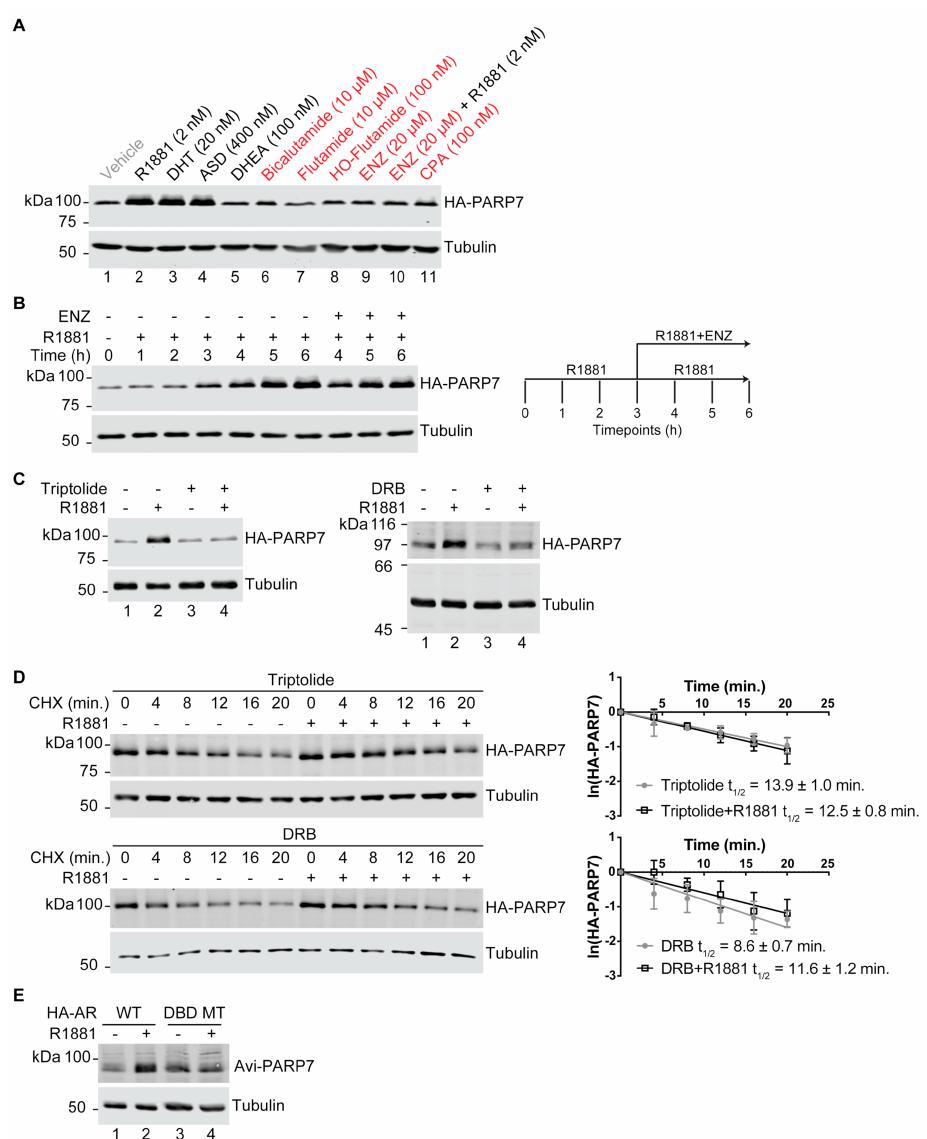
Figure 6. AR-dependent transcription is required for PARP7 stabilization. ( A ) PC3-Flag-AR/HA- PARP7 cells were treated with indicated androgens (black) and anti-androgens (red) for 6 h and analyzed by immunoblotting. DHT: dihydrotestosterone, ASD: androstenedione, DHEA: dehy- droepiandrosterone, HO-Flutamide: hydroxyflutamide, ENZ: enzalutamide, CPA: cyproterone acetate. ( B ) PC3-Flag-AR/HA-PARP7 cells were treated with R1881 (2 nM) for 3 h, and then treated for an additional 3 h with R1881 in the presence or absence of ENZ (20 µ M) (schematic). Harvested timepoints were analyzed by immunoblotting. ( C ) PC3-Flag-AR/HA-PARP7 cells were pre-treated with transcription inhibitors triptolide (1 µ M) or DRB (100 µ M) for 1 h, followed by 6 h of androgen (2 nM R1881) treatment and analyzed by immunoblotting. ( D ) PC3-Flag-AR/HA-PARP7 cells were treated as described in (C). Cycloheximide (CHX) time course experiments were carried out under the indicated conditions and analyzed as described in Figure 2A. Plots show mean ± SD from three independent experiments and protein half-lives. ( E ) Avi-tagged PARP7 was co-expressed in PC3M cells stably expressing HA-tagged AR (either wildtype [WT] or V582F mutant which targets the DNA binding domain [DBD MT]). Cells were treated with androgen (2 nM R1881, 6 h) and analyzed by